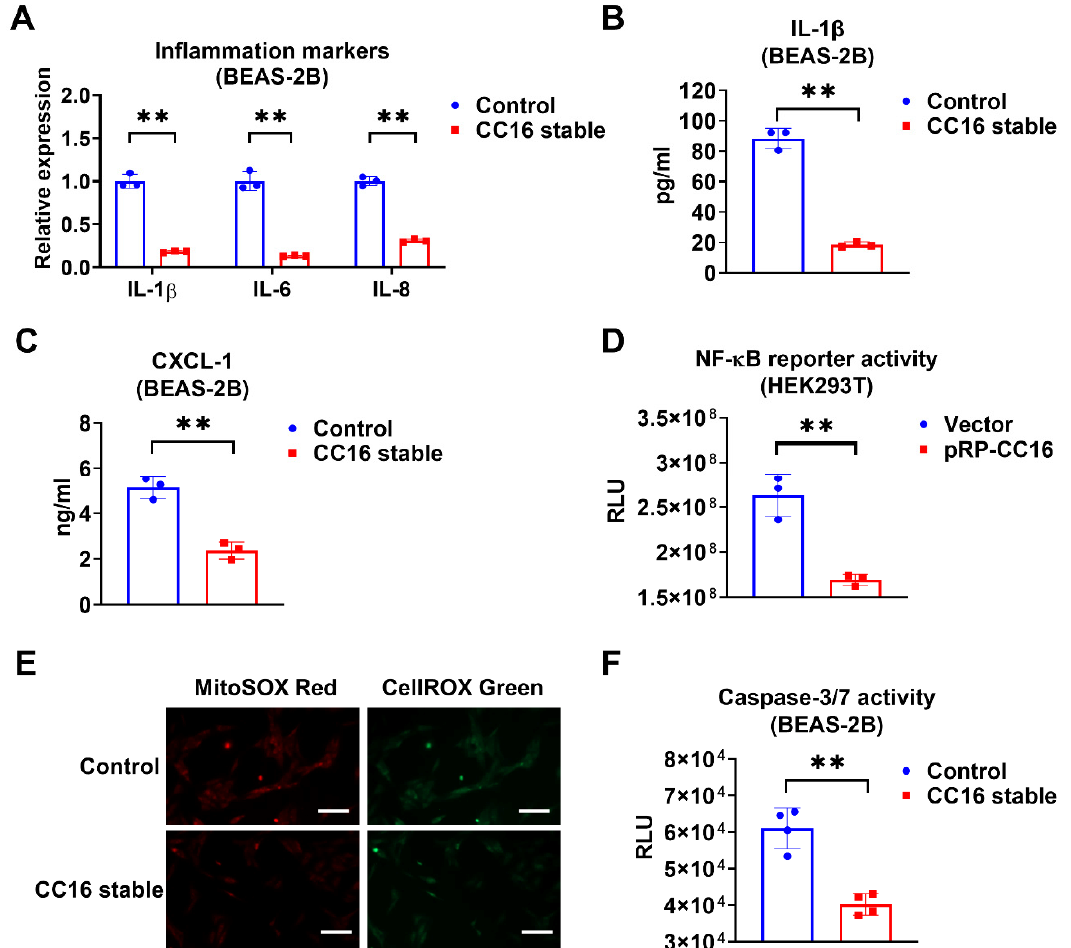
Figure 4. Overexpression of CC16 decreases inflammation, ROS, and apoptosis during K. pneu infection. ( A – C ) BEAS-2B and BEAS-2B-CC16 were infected with a 1:5 ratio of K. pneu for one hour and then incubated in 50 µg/mL of gentamycin for 48 h. The mRNA levels of proinflammatory cytokines IL-1 β , IL-6, and IL-8 were determined by real-time PCR ( A ). The secretions of IL-1 β ( B ) and CXCL-1 ( C ) were measured using ELISA. ( D ) NF- κ B reporter activity in HEK293T cells was measured 24 h after 200 ng/mL of LPS treatment. ( E , F ) BEAS-2B and BEAS-2B-CC16 were infected with a 1:5 ratio of K. pneu for one hour and then incubated in 50 µg/mL of gentamycin for 48 h. Cells were stained with MitoSOX and CellROX to detect the mitochondrial and cellular oxidative stress levels. Scale bars = 100 µm ( E ). The activities of Caspase 3/7 were measured after infection ( F ). Results represent mean ± SD of 3 independent experiments. ** p < 0.01. 3. Discussion For several decades, CC16 as a circulating biomarker for lung diseases has been ex- tensively investigated [17]. In the majority of studies, CC16 levels were found lower in asthma and COPD. However, CC16 levels in serum were higher in ARDS, pulmonary fibrosis, and sarcoidosis [12–23]. The bronchial tubes (bronchi and bronchioles) are pre- dominantly inflamed in asthma and COPD [33], and it has been previously reported that Clara cells are mainly located in bronchial tubes [34]. This is a potential explanation for reduced CC16 in these clinical conditions, as well as for our experimental observations in BEAS-2B and NHBE cells. In contrast, the alveolar epithelium and the tissues around and between the alveoli are mainly affected by pulmonary fibrosis and pulmonary sarcoidosis [35,36]. Similarly, ARDS is characterized by acute inflammatory damage with respect to the alveolar capillary barrier causing an increase in vascular permeability [37]. In ARDS, pulmonary fibrosis, and sarcoidosis, the large and small airways are not directly injured as they are in asthma and COPD. Furthermore, it has been previously reported that Clara cells have a role in repairing damaged epithelium [38]. They are involved in wound repair